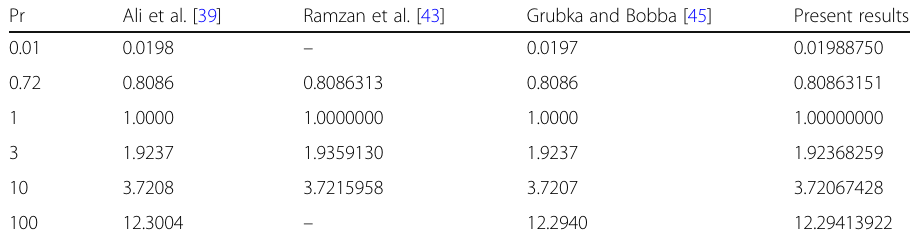
Table 1 Comparison of − θ ′ (0) for various values of Pr when M = β h = β i = λ = Nr = K = Nb = Nt = Le = φ = 0 Pr Ali et al. [39] Ramzan et al. [43] Grubka and Bobba [45] Present results